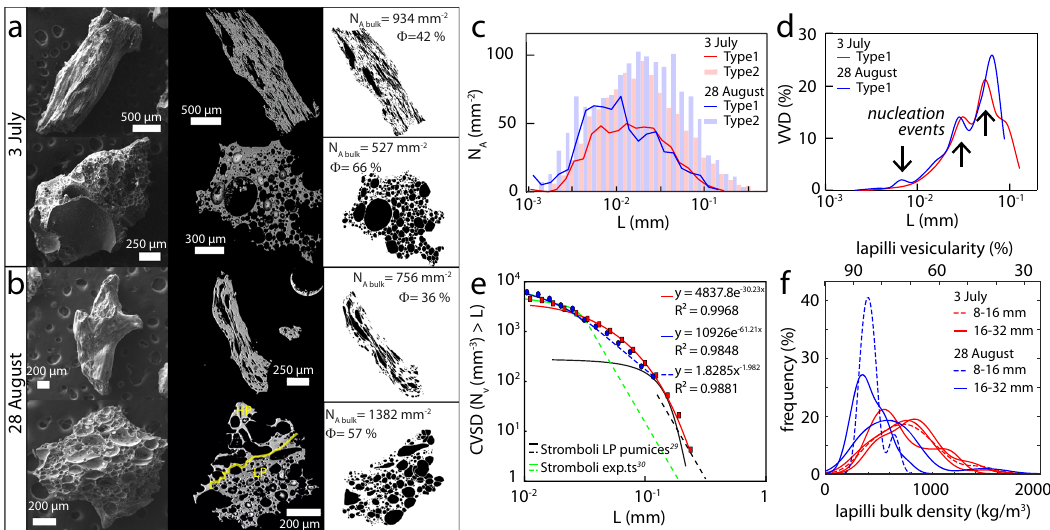
Fig. 6 Morphological and physical features of ash and lapilli. a – b SEM images of selected LP clasts from the two paroxysms, showing external morphology and internal texture (left and center columns), and binary images (right column; vesicles in black with Φ = vesicle area fraction %, and N A bulk = total number of vesicles per mm − 2 within each class). c 2D distribution of the major axis of the best- fi t ellipse (L) for Type1 (lines) and Type2 (bars) vesicles in number density ( N A mm − 2 ). d 3D volume distribution of Type1 vesicles (VVD). Arrows point to nucleation events. e Log-plot of the cumulative vesicle size distribution (CVSD), i.e., the number density of 3D (N v , Type1) vesicles larger than L (major axis of the vesicle best- fi t ellipse) against L. Equations of power-law (dashed) and exponential (solid) curves fi tting the data are shown together with the R 2 . For comparison, published data on 0.01 – 1mm vesicles data Stromboli 2003 and 2007 paroxysms 29 (black lines) and experiments 30 (green lines) are shown. f Density distribution of lapilli in the size range 8 – 16 and 16 – 32mm and corresponding estimated vesicularity distributions for 3 July (red lines) and 28 August (blue lines, See “ Methods ”